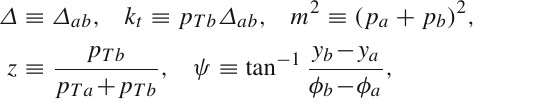
the subjet axis, and z is the transverse momentum fraction of the branching. The construction of the Lund jet plane can be schematically understood with the help of Fig. 1. The (pri- mary) Lund plane associated with the initial proto-jet repre- sents a two-dimensional parametrisation of the phase space available to further radiation from it. This is indicated by the large (blue) triangle in the ln k t − ln 1 /Δ plane in Fig. 1. Each subsequent primary emission along the hard branch of the tree is shown in red, and it forms a new leaf of the Lund plane, from which secondary emissions will be radiated, indicated by orange leaves. The procedure iterates through all branches of the clustering history, leading to a complete representation of the jet’s substructure. In particular, the structure of the pri- mary Lund jet plane can be computed accurately with per- turbative methods [65] and measured experimentally